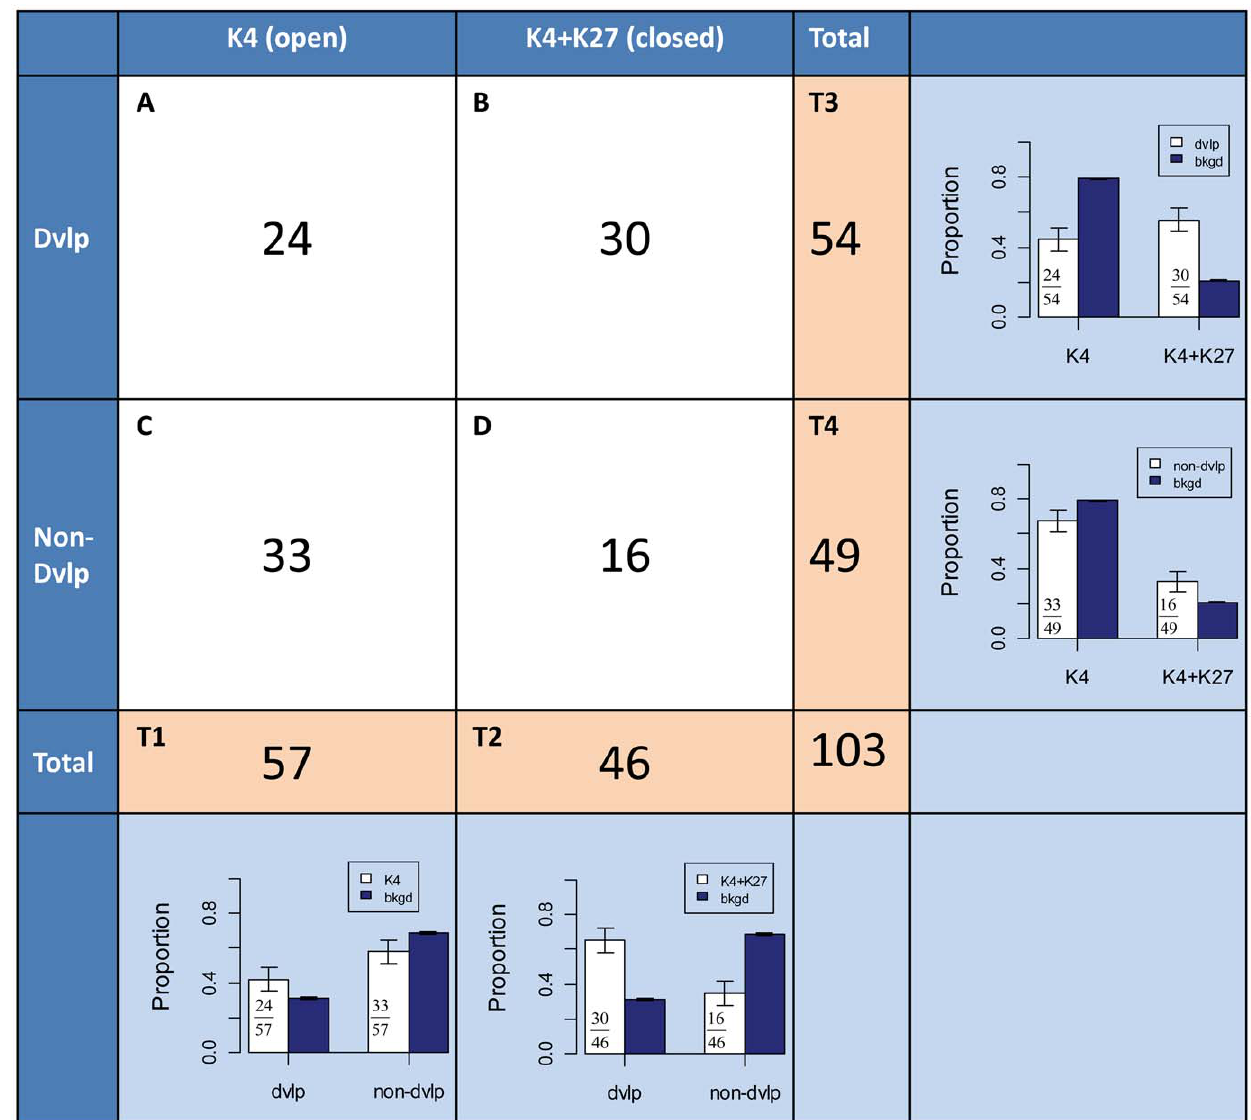
Figure 5. Effect-evaluation matrix for gene function and chromatin status of SLOs. As shown in the inner 2x2 matrix (white area), SLOs are divided into four groups according to their associated histone mark and gene function. ‘K4’ stands for H3K4me3; ‘K4 + K27’’ stands for H3K4me3 + H3K27me3; ‘Dvlp’ stands for developmental gene; ‘Non-Dvlp’ stands for non-developmental gene. Bar plots in the most right column show the proportion of SLOs associated with different histone marks compared with the genomic background when gene function is controlled. Bar plots in the bottom row show the proportion of SLOs associated with different gene functions compared with the genomic background when chromatin status is controlled. Error bars are standard errors derived from the total number of genes (sample size) in each gene set.